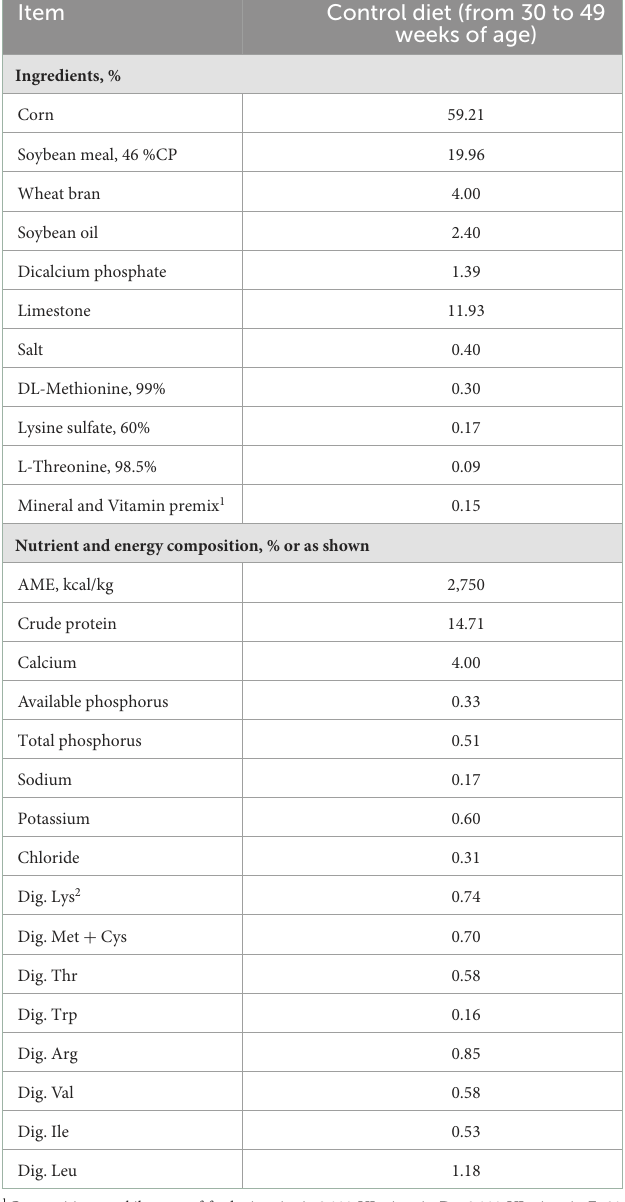
TABLE 1 Ingredient and nutrient composition of the control diets, as-is. Item Control diet (from 30 to 49 weeks of